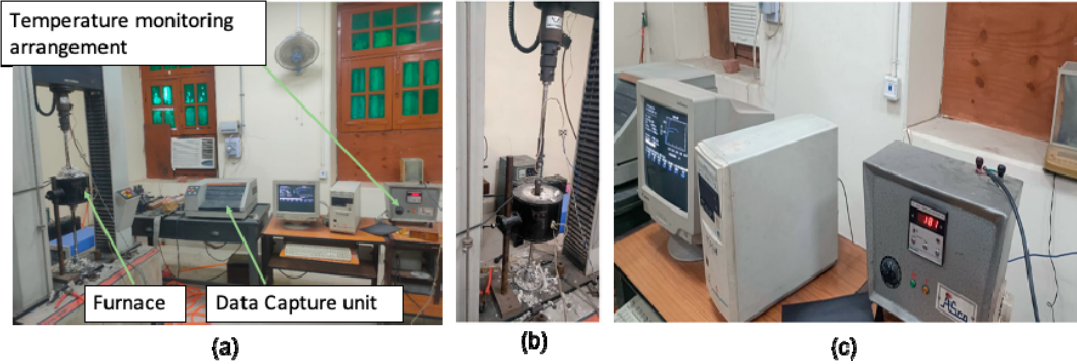
Figure 1. ( a ) Setup for tensile testing with heating furnace; ( b ) Sample with furnace; ( c ) Temperature monitoring system.